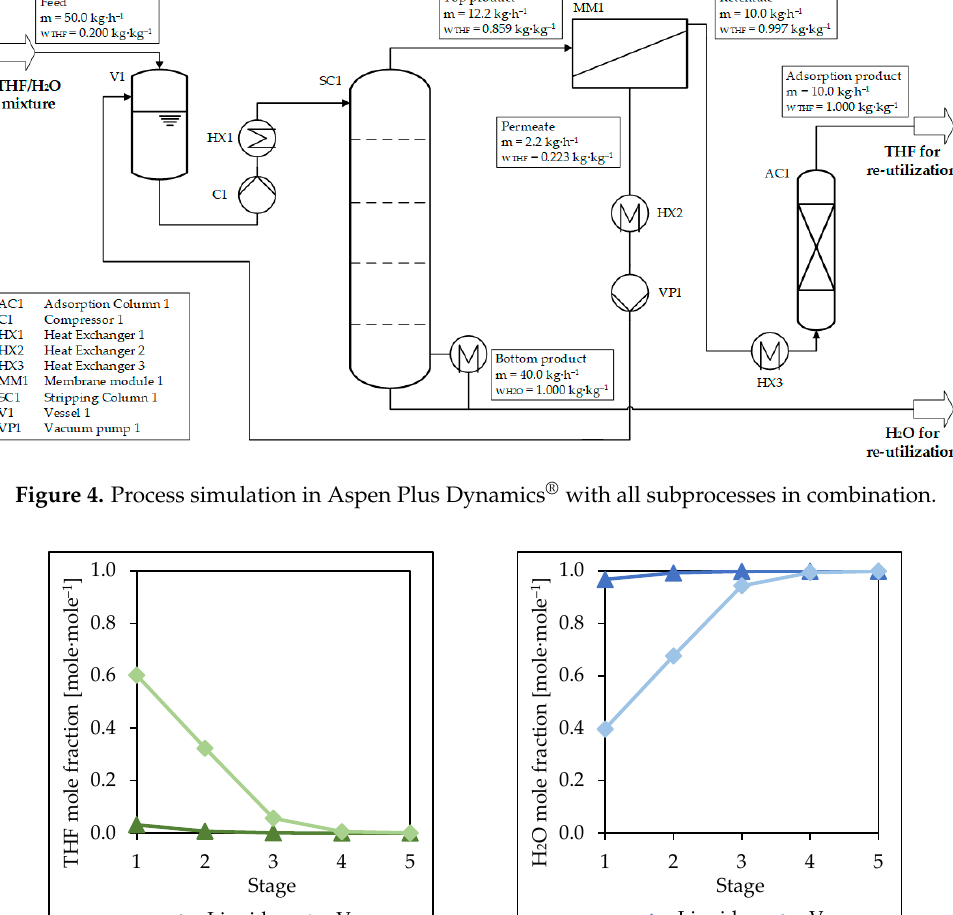
( b ) Figure 6. ( a ) Retentate mole fraction of THF and Water over the membrane area and ( b ) breakthrough curve of Water of ad- sorption column. It is observed from the data that the high purity of the THF can be achieved via the combination of the dif- ferent sequential separation processes. Investigation of Energy Consumption In view of the fact that a sustainable, resource-saving process is to be developed, its energy consumption is a key parameter. Therefore, the energy consumption of the process was investigated. Since this depends to a large extent on the operating pressure, the influ- ence of this factor was analyzed by variation. For this purpose, seven different feed pres- sures between 2 and 8 bar were investigated. Figure 7a shows the energy consumption for the whole process depending on different feed pressures, which includes the individual energy consumptions of pumps, heat exchangers, and the reboiler for the operation of the stripping column. The main part of the energy consumption consists of the heating power of the hybrid process with approximately 80%. Just under 20% results from the necessary cooling power, while the remaining energy is used for electrical power. Besides the total energy consumption, Figure 7a shows the data for the energy consumption of the strip- ping column as a single data set. This includes the reboiler of the column itself and the heater for the feed stream. It can be observed that the first process step with stripping accounts for the largest share of the energy consumption of the entire process. The mem-